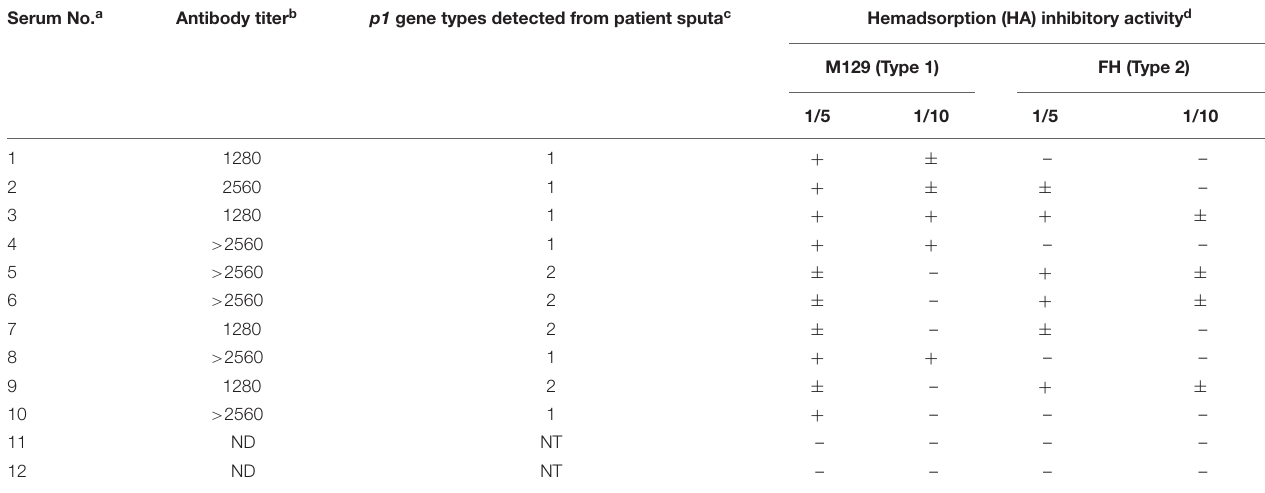
a Serum number corresponds to the lane number of Figure 5B . b Antibody titer was measured with Serodia Myco II kit (Fujirebio, Tokyo, Japan); ND, not determined. c Detection and typing of the p1 gene was performed by the nested PCR method as a part of previous study (Kenri et al., 2008); NT, not tested. d Five to ten colonies of M. pneumoniae M129 (type 1) or FH (type 2) strains were formed on PPLO agar cast in a 24-well microplate (1.5 ml PPLO agar per well). Colony-forming wells were soaked with 1 ml of phosphate-buffered saline (PBS) for 5 min at room temperature. After removal of PBS, 0.1 ml of diluted patient serum (fivefold or 10-fold dilution by PBS) was added to the well and incubated for 20 min at 37 ◦ C. After removal of the patient serum, 0.5 ml of a diluted sheep red blood cell (RBC) suspension (100-fold dilution by PBS) was added to the well and incubated for 20 min at 37 ◦ C. After incubation, excess RBCs were removed by washing with 1 ml of PBS three